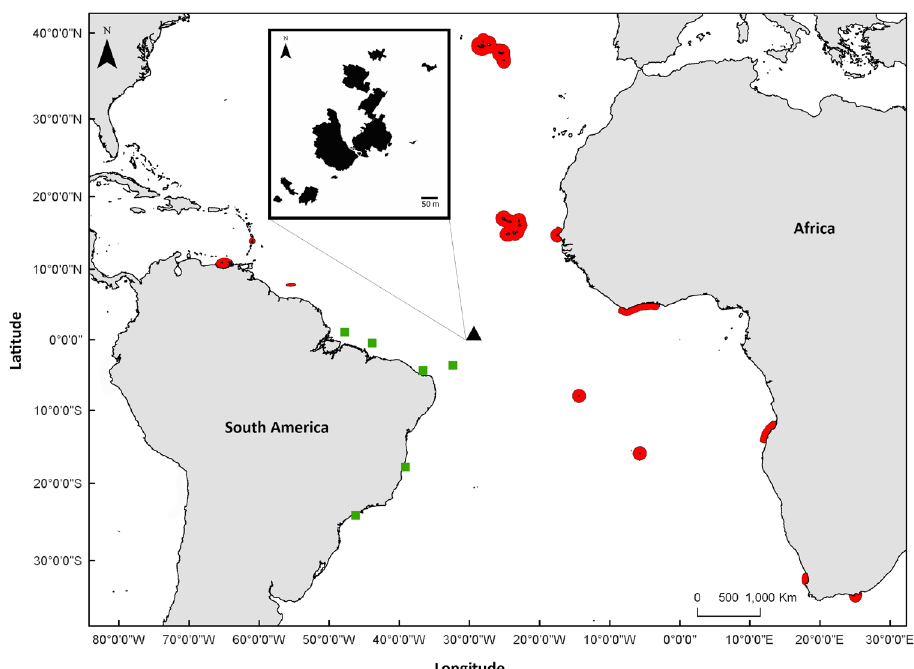
FIGURE 1 | Geographical location of the Saint Peter and Saint Paul Archipelago (SPSPA; black triangle and inset) in the equatorial Atlantic Ocean. Red indicates Mobula tarapacana confirmed occurrences in the Atlantic Ocean (IUCN, 2019), while green squares are known occurrences in Brazilian